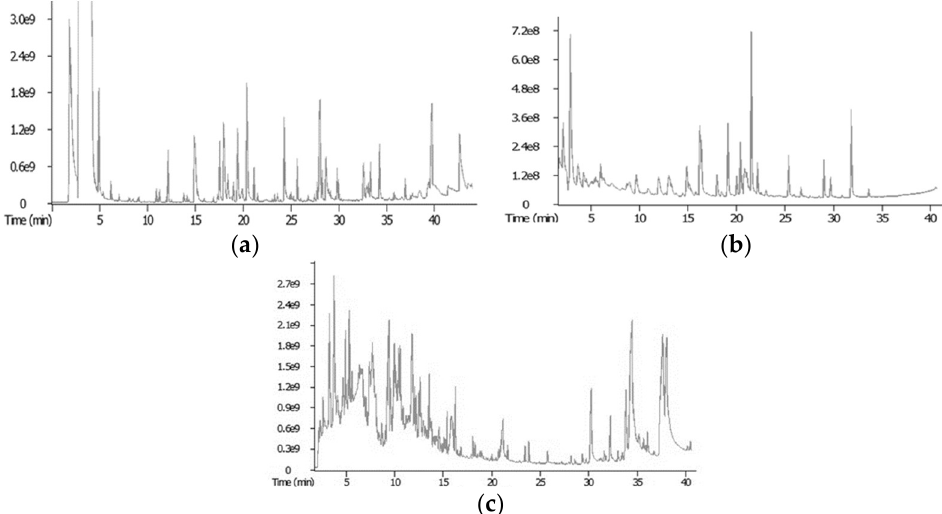
Figure 2. Total ionic chromatogram of volatile components in the three-year aged Jinhua ham extracted by SAFE ( a ), SPME ( b ), and NT ( c